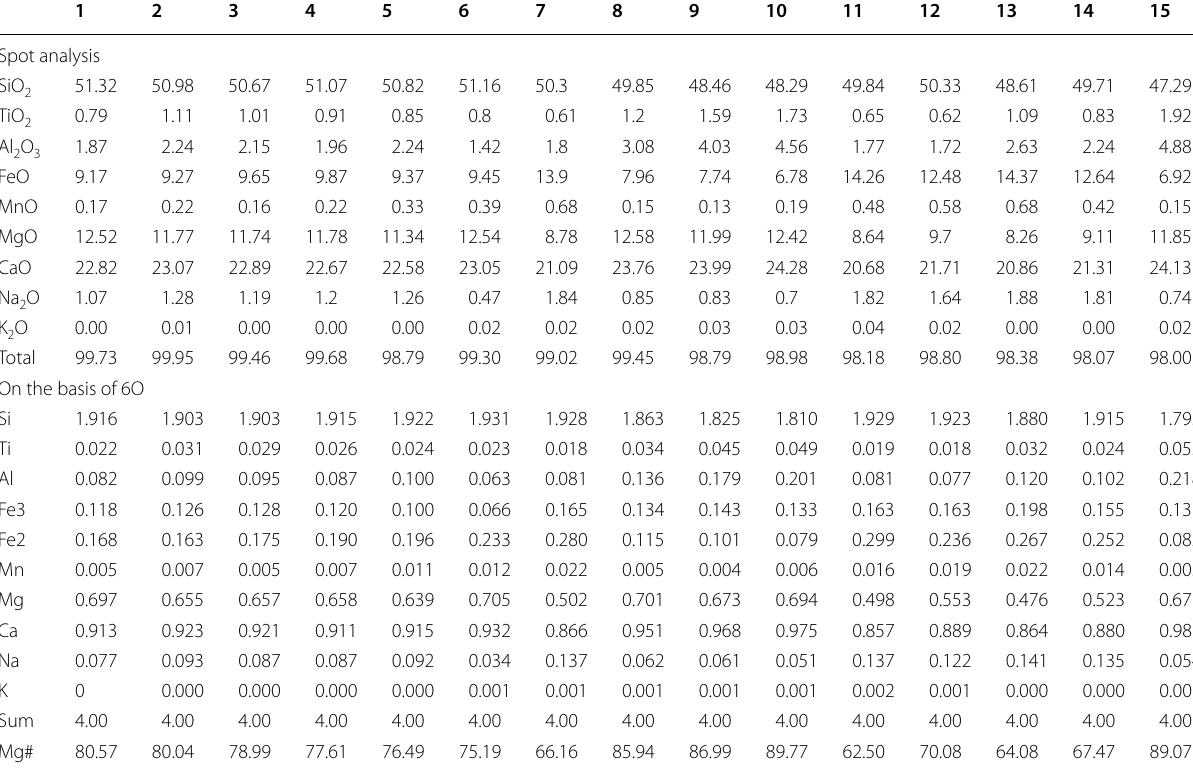
Table 2 Quantitative mineral chemistry